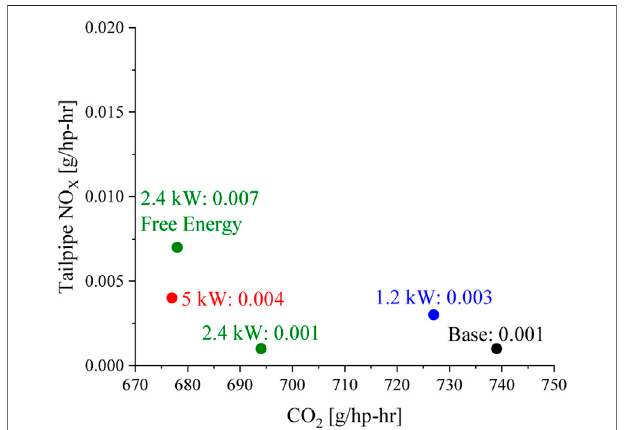
FIGURE 12 | Beverage cycle results.